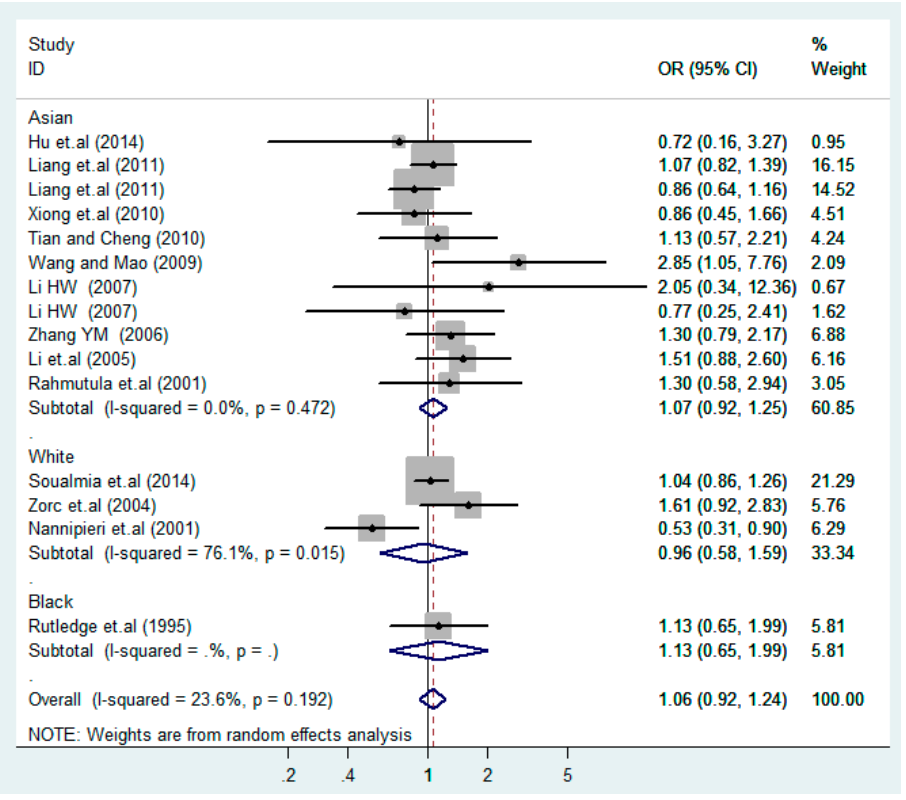
Figure 9. Ethnic subgroups analysis of T2238C additive model (C vs. T). Int. J. Environ. Res. Public Health 2016 , 13 , 458